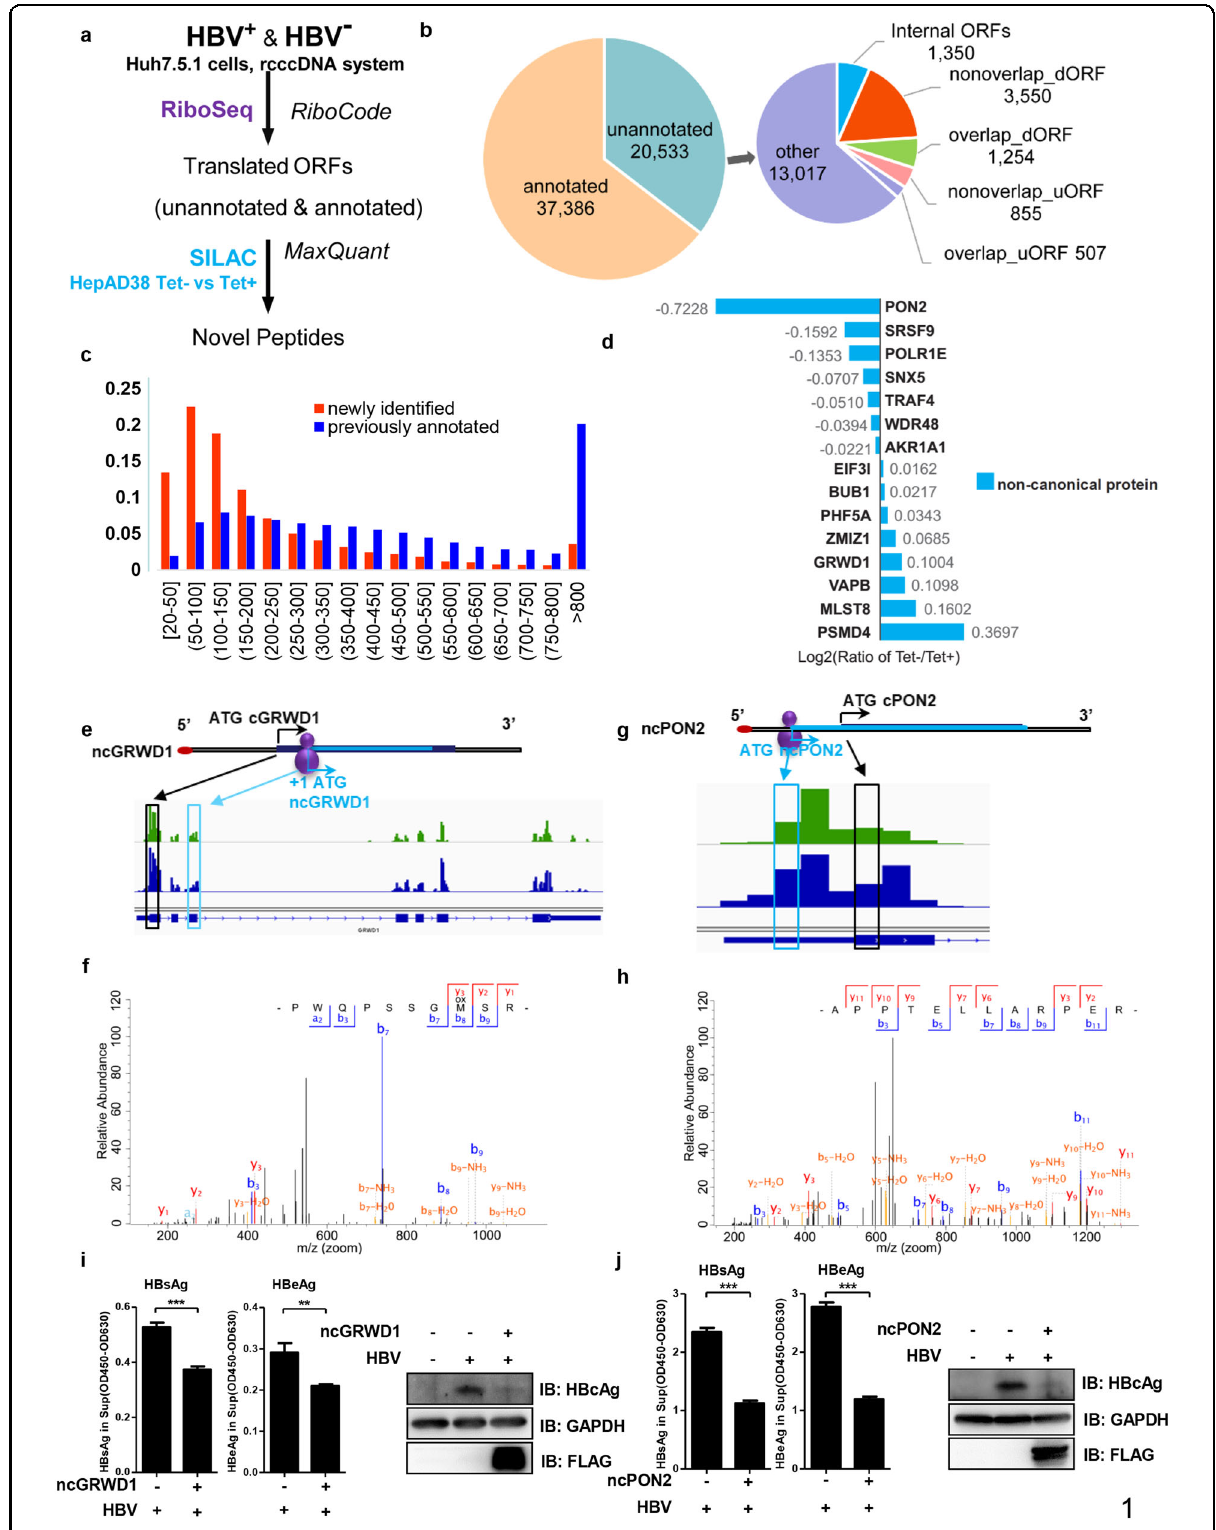
Fig. 1 (See legend on next